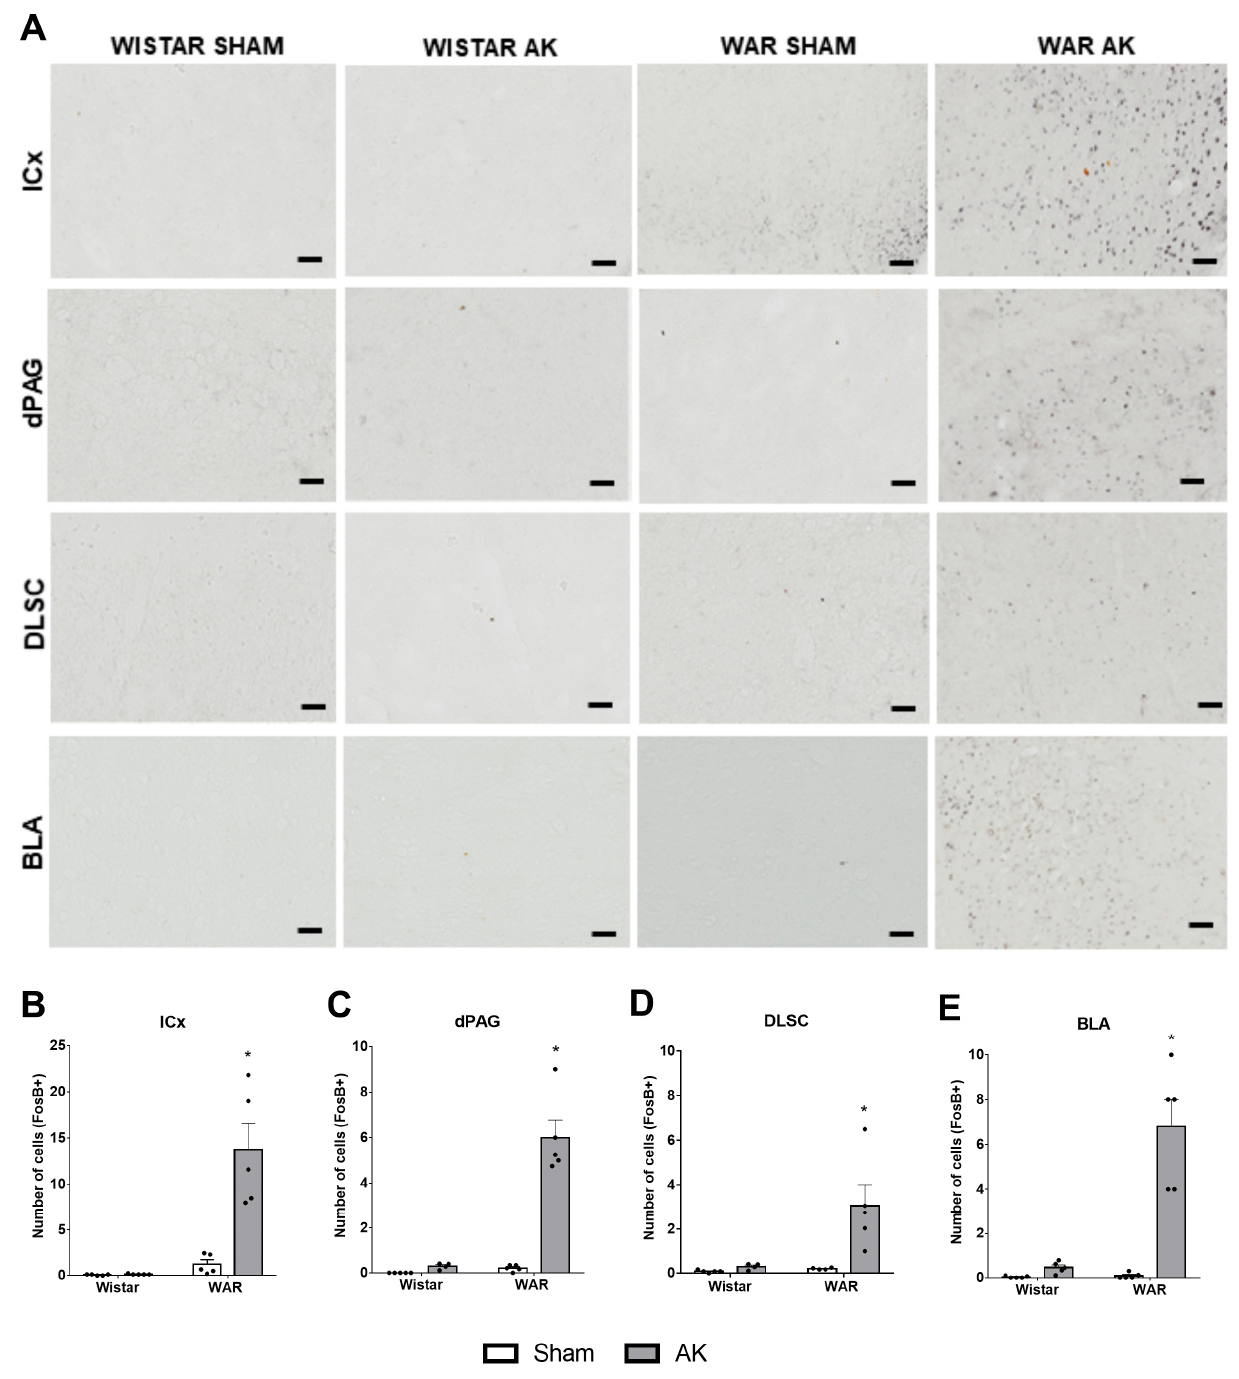
Figure 5. FosB immunostaining after the audiogenic kindling (AK) protocol. ( A ) Representative images of every analyzed area in each experimental group. FosB+ neurons are characterized by black dots, which indicate the nucleus of each immunopositive neuron. ( B ) inferior colliculus cortical area—ICx. ( C ) dorsal periaqueductal gray matter—dPAG. ( D ) deep layers of superior colliculus—DLSC. ( E ) basolateral amygdala nucleus—BLA. * p < 0.05 Tukey test compared to WAR- Sham. Data are expressed as mean ± standard error mean. N = 4–5/group. Scale bars = 200 µ